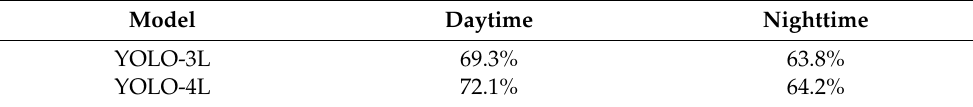
Table 2. Detection performance between the optimized and the original YOLO models. Model